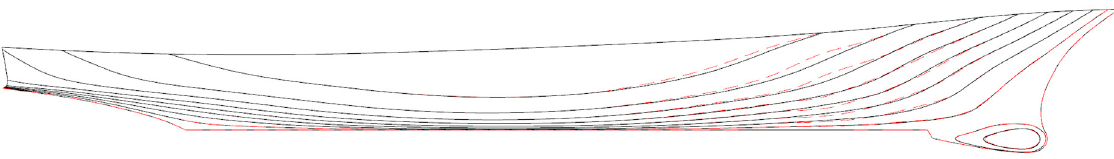
Figure 16. Comparison of body plan views of direct optimized and original hull forms.